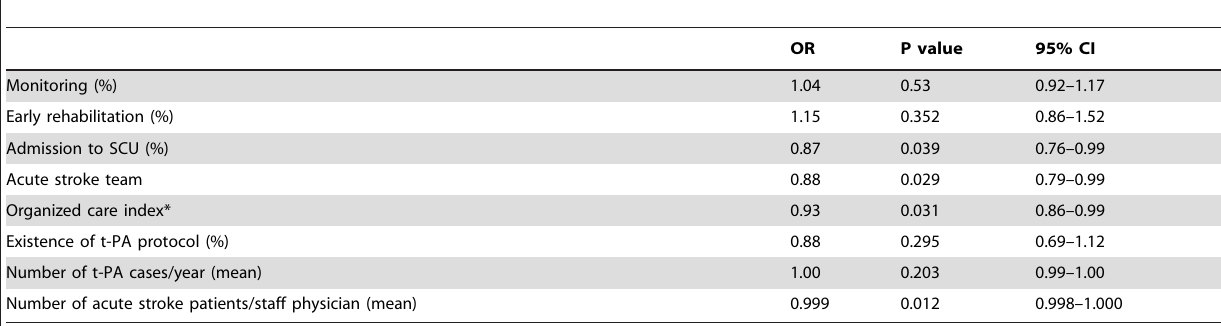
Table 11. Impact of processes of stroke care on in-hospital mortality after all types of